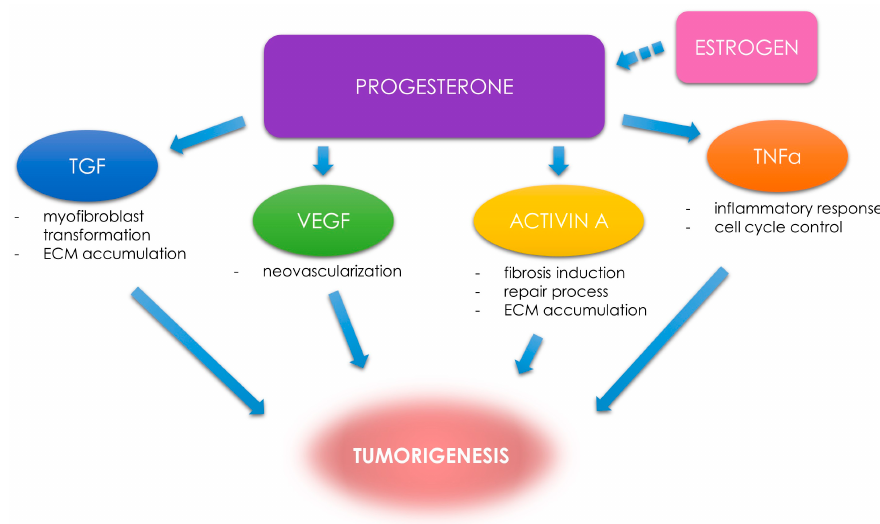
Figure 3. Progesterone and progesterone-related factors. The role of selected factors in UF tumorigenesis. Transforming growth factor (TGF); vascular endothelial growth factor (VEGF); tumor necrosis factor α (TNF- α ); extracellular matrix (ECM). Estrogen as a factor preparing the tumor to be stimulated by progesterone (dotted arrow).